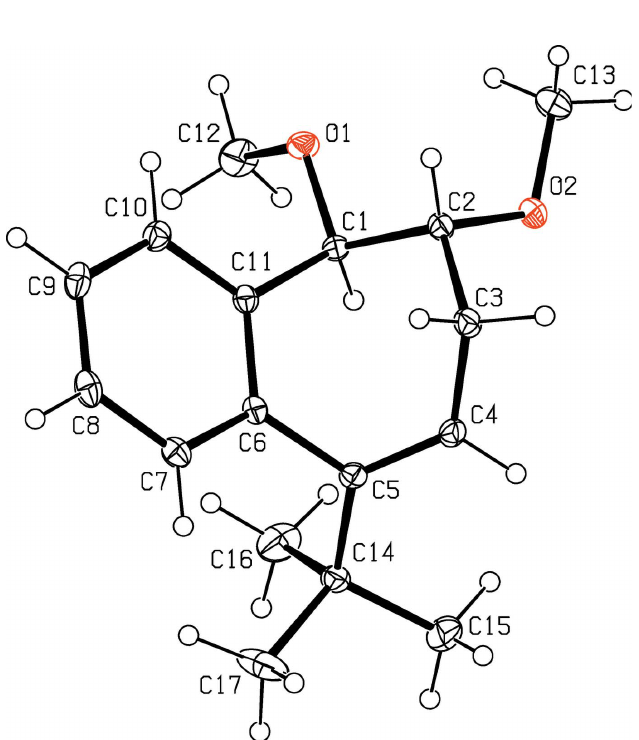
Figure 2 The molecular structure of the title compound, with displacement ellipsoids drawn at the 30% probability